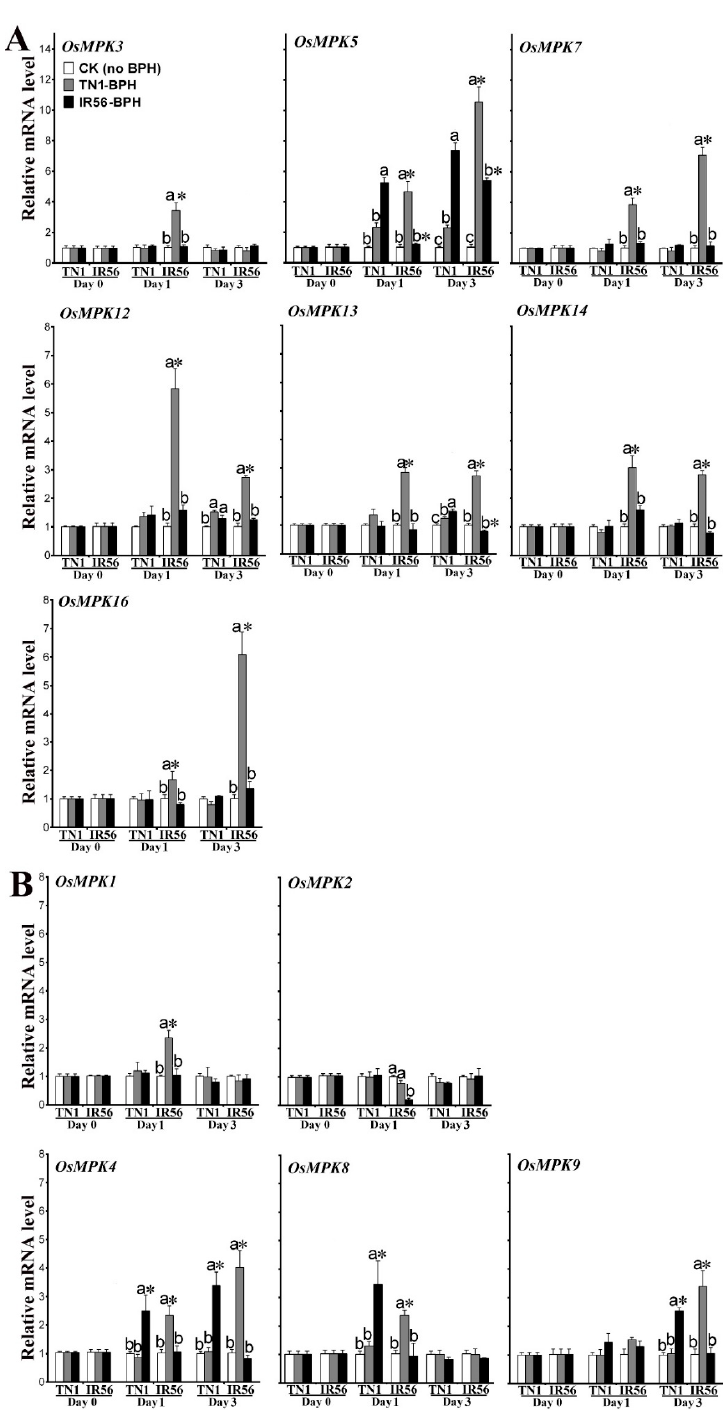
Figure 2. The expression profiles of the 12 OsMPKs showing significant induced expressions in the IR56 and TN1 rice varieties under infestation of TN1-BPH and IR56-BPH at 0–3 days post-infestation. Data are denoted as mean ± standard error (SE) and analyzed by three-way ANOVA followed by Tukey’s honestly significant difference (HSD) test. ( A ) OsMPK s showing significant differences in the main (rice varieties, BPH populations, and days post-infestation) and all interaction effects. ( B ) OsMPK s showing significant differences in any of the main effects or any of the interaction effects. * represents a significant difference with TN1 rice ( p < 0.05); different letters above the bars represent significant differences ( p < 0.05) among each TN1-BPH- and IR56-BPH-infested rice variety, and the control (CK, rice not infested with BPH). No significant difference among samples was not denoted by any